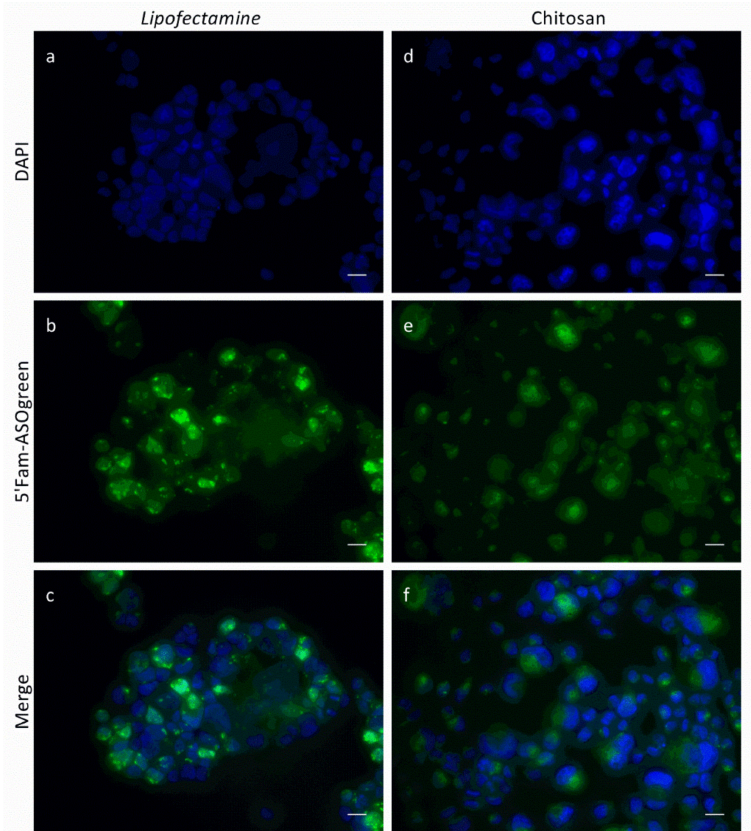
Figure 7. Representative confocal laser scanning microscope (CLSM) images of NCI-H441 cells transfected with 5 (cid:48) Fam-ASOgreen. Cells were transfected using ( a – c ) Lipofectamine and ( d – f ) CS. Images were taken 24 h after transfection. ( a , d ) DAPI; ( b , e ) 5 (cid:48) Fam-ASOgreen; ( c , f ) Merge (scale bar = 20 µ m).